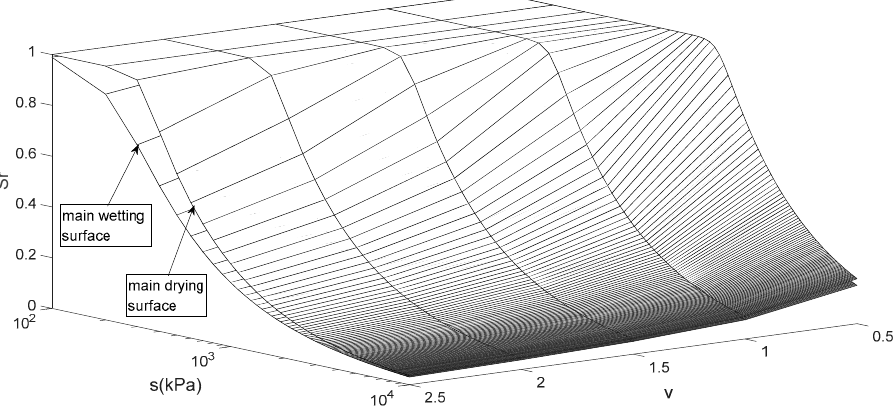
Figure 2. Typical main drying and wetting surfaces of Speswhite kaolin in e ∼ lns ∼ s r space (Tarantion’s model).